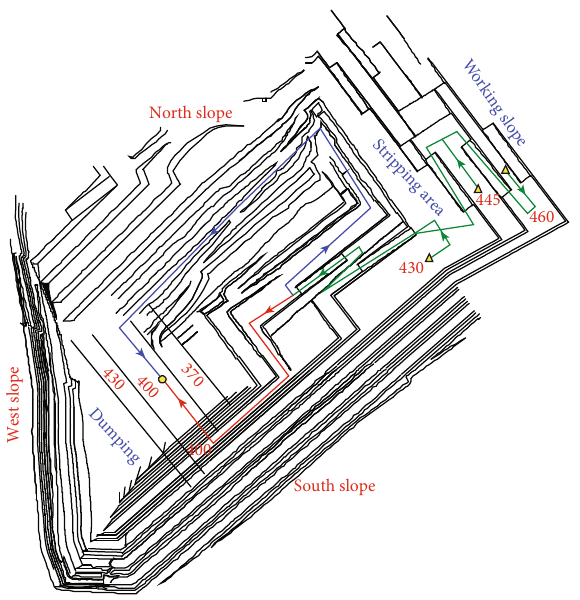
Figure 5: Material transportation diagram for the corresponding work slope on the west slope in-row platform.